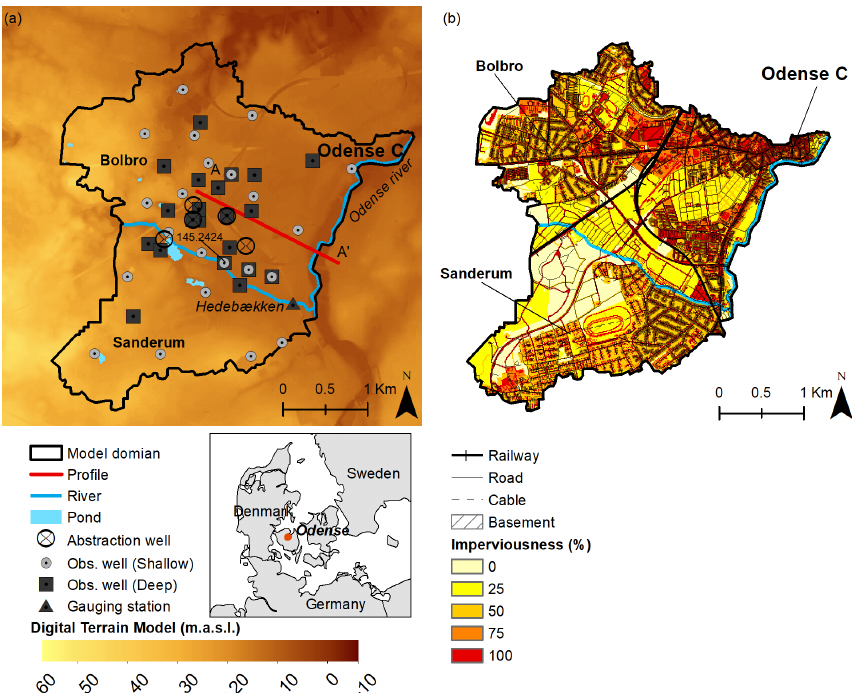
Figure 1. Maps of the model domain, which is part of the city of Odense, Denmark. Panel (a) displays a digital terrain model from the Danish National Agency for Data Supply and Infrastructure (2019), with the locations of the observation points and abstraction wells provided by GEUS (2019). Panel (b) depicts the imperviousness of the land cover retrieved from Levin et al. (2012) and the subsurface infrastructure provided by LaBianca (2023a) and the SDFI